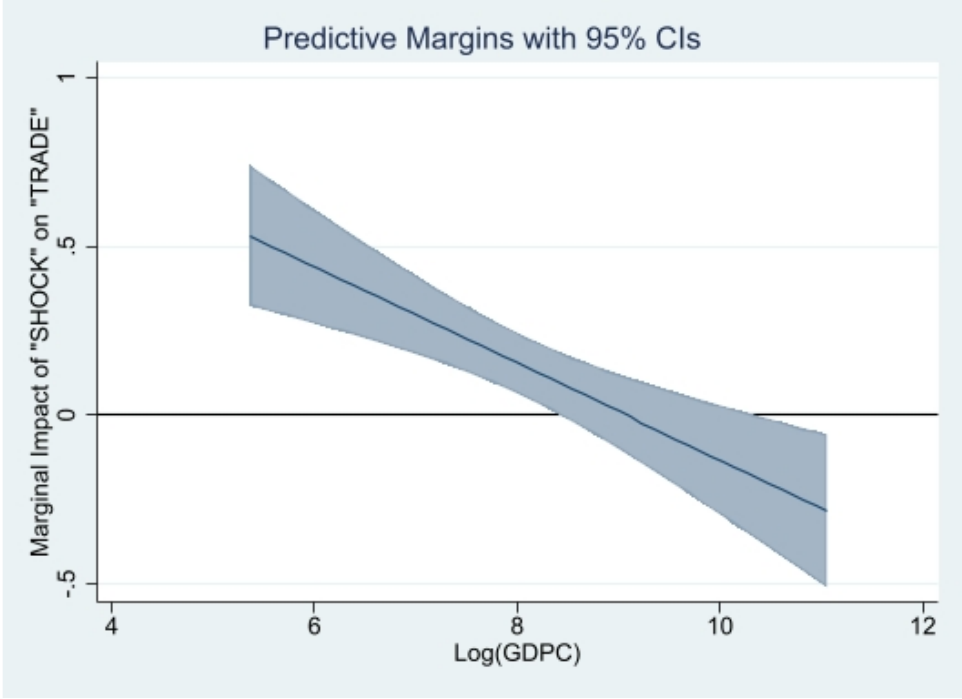
Figure 8. Marginal impact of “SHOCK” on “TRADE” for varying levels of the real per capita income. Source: Author.